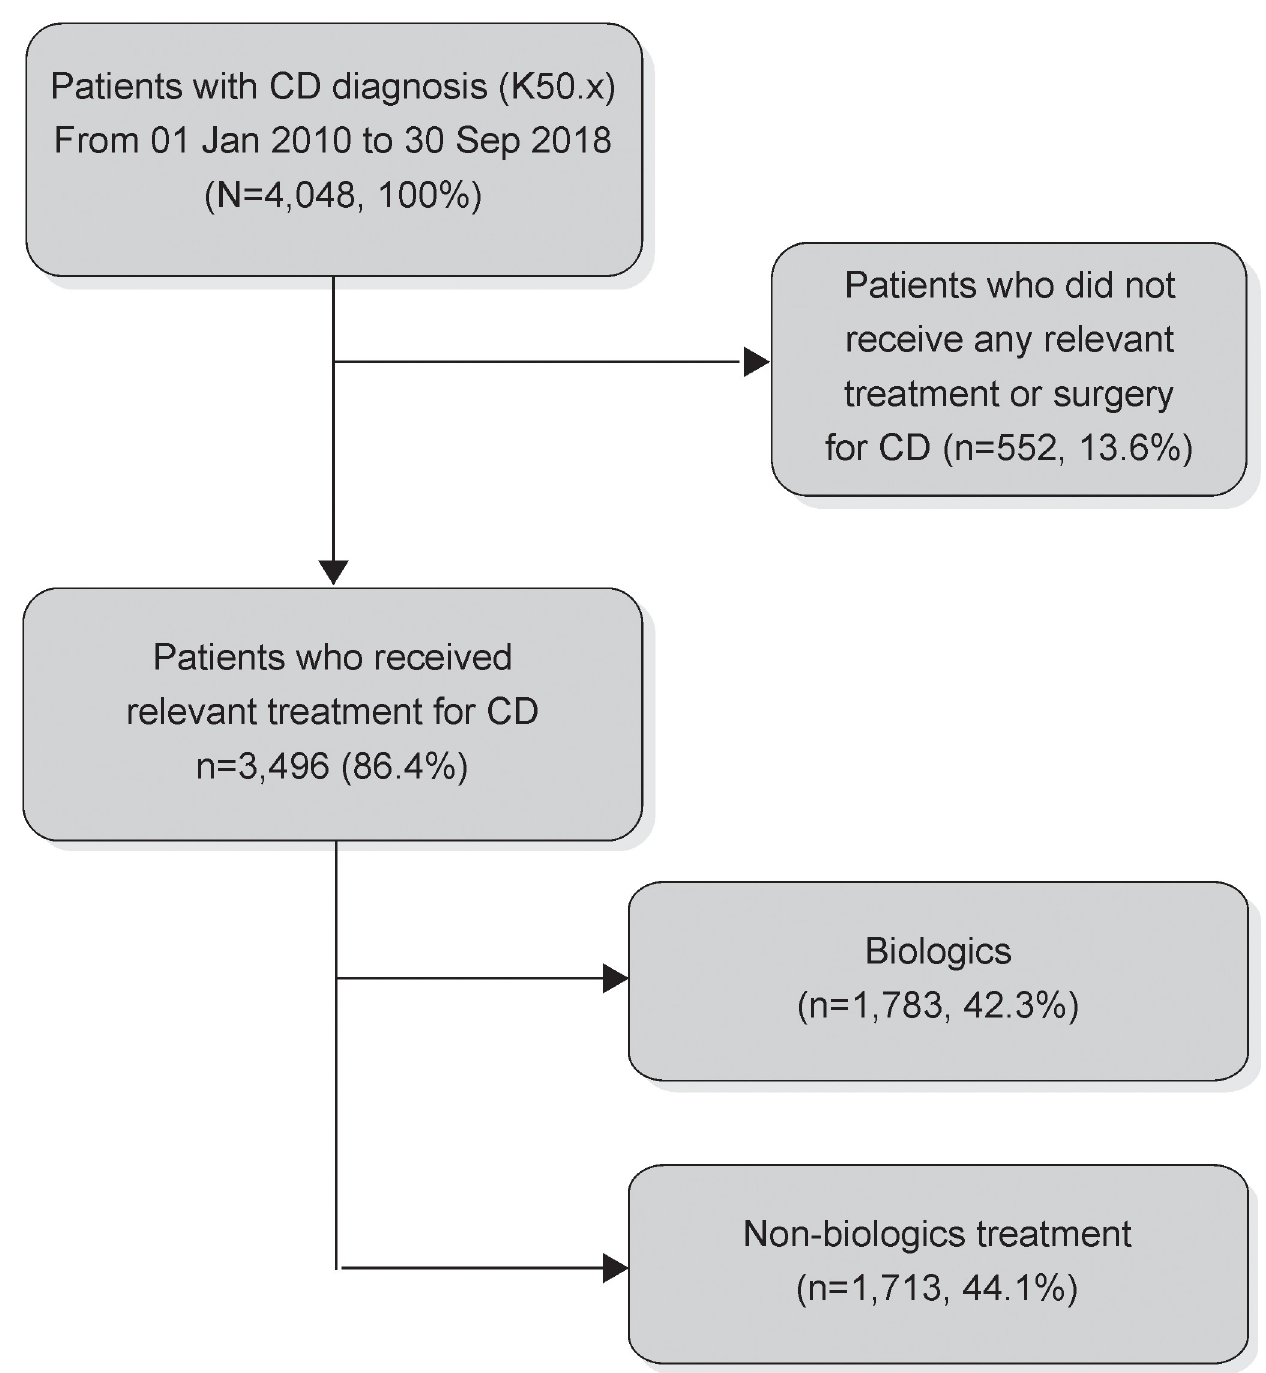
Fig 3. Selection flow